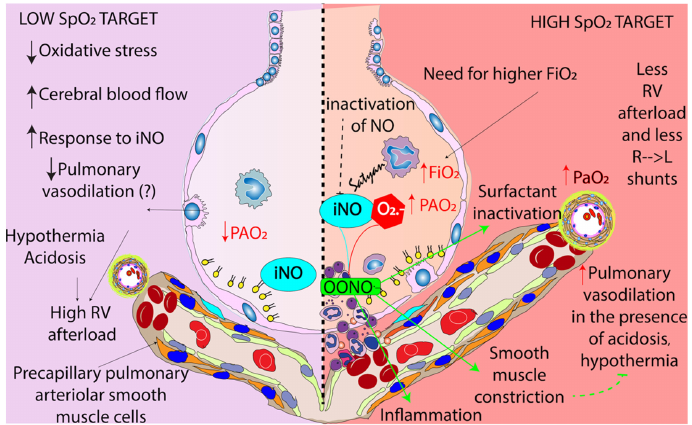
Figure 4. Benefits and risks associated with targeting lower ( left panel ) and higher ( right panel ) oxygen targets. Lower targets may be associated with lower alveolar oxygen tension (PAO 2 ), possi-